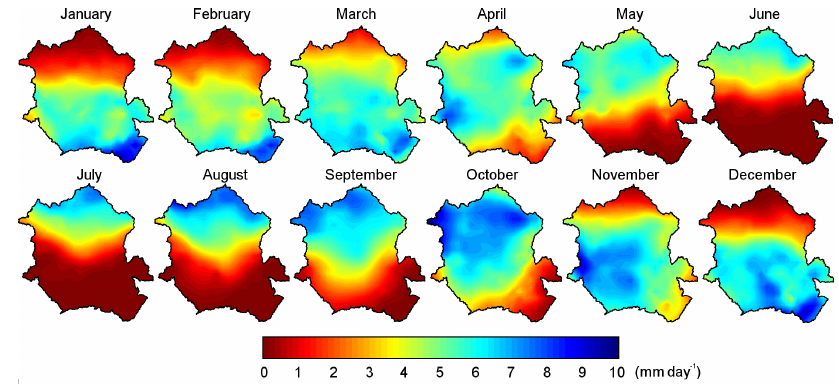
Figure 2. Monthly mean precipitation over the CRB for 1980–2010. The data are from CRU TS v3.23.